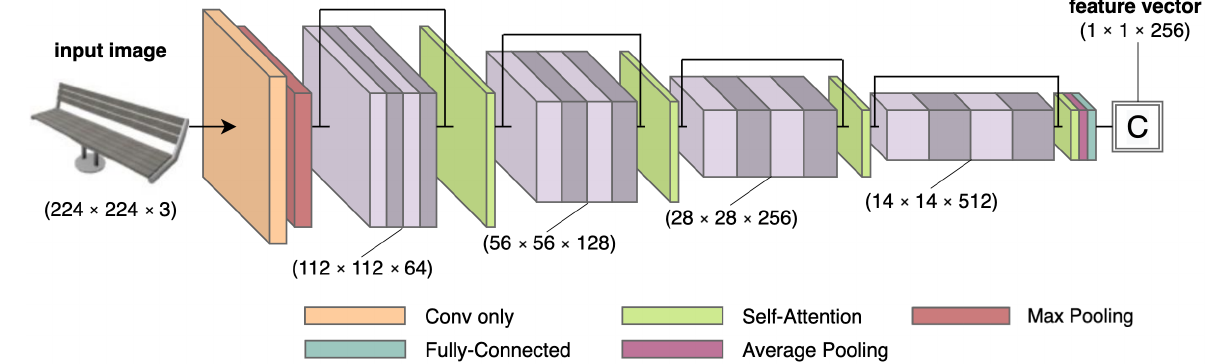
Figure 8. The “attentioned” ResNet-18 [34] network with four self-attention blocks [37] added to it. This encoder network is used by [8] to extract image features, which are fed to a decoder with five Conditional Batch Normalization blocks followed by an occupancy